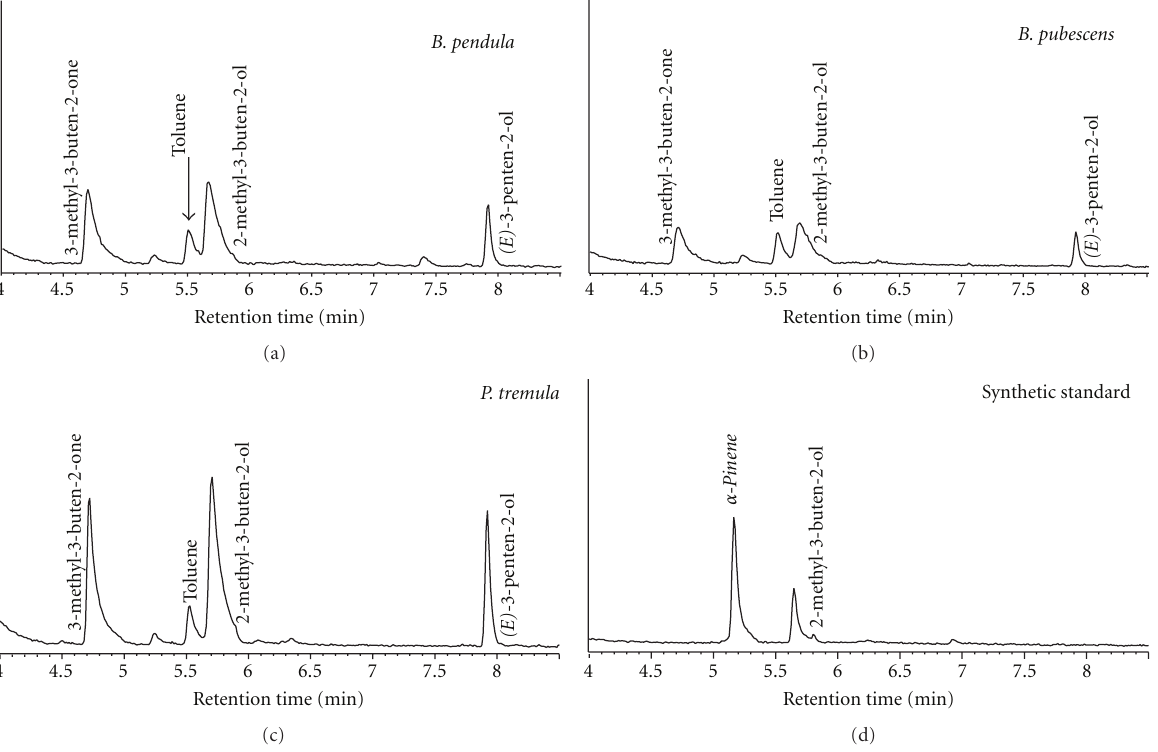
Figure 1: Gas chromatograms from bark extracts of B. pendula, B. pubescens , and P. tremula, and synthetic standard of 2-methyl-3-buten- 2-ol (MB).